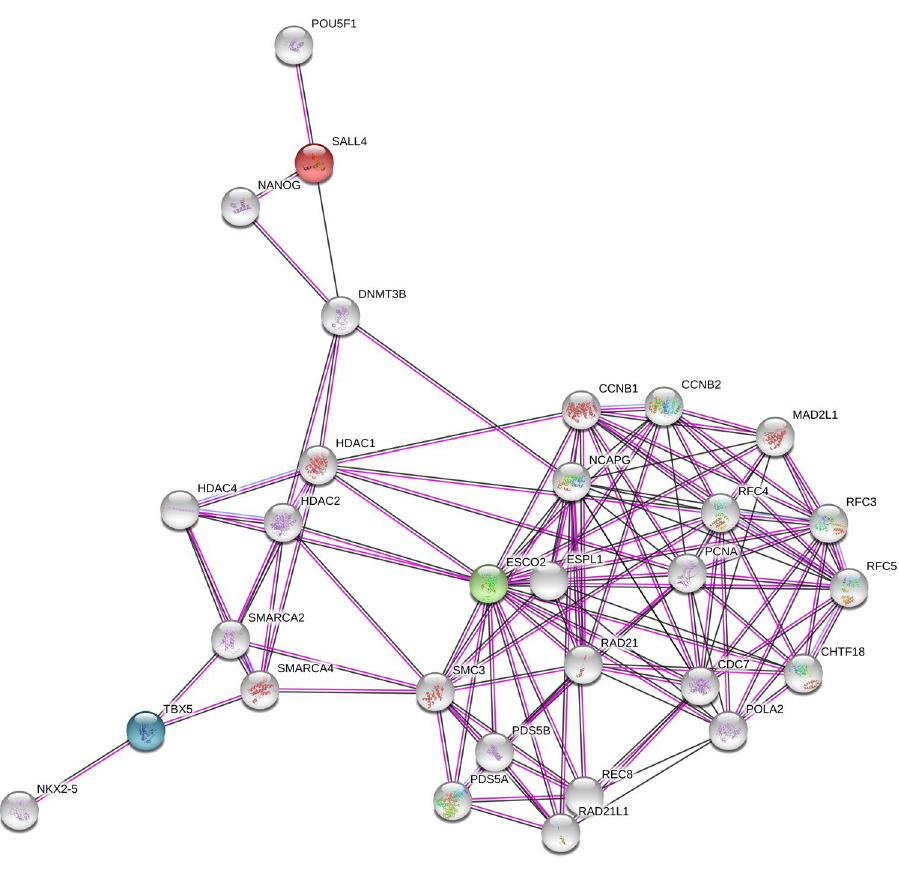
Figure 3. Protein–protein interaction network including ESCO2, SALL4 and TBX5 proteins. These three proteins do not interact directly, but through others secondary binding